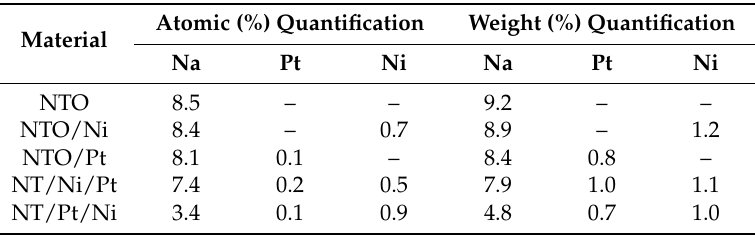
Figure 5. SEM images of NTO ( a , b ), NTO/Ni/Pt ( c ), and NTO/Pt/Ni ( d ), and EDX analysis of NTO/Ni/Pt ( e ) and NTO/Pt/Ni ( f ). Table 2. Elemental quantification of the synthesized catalysts.